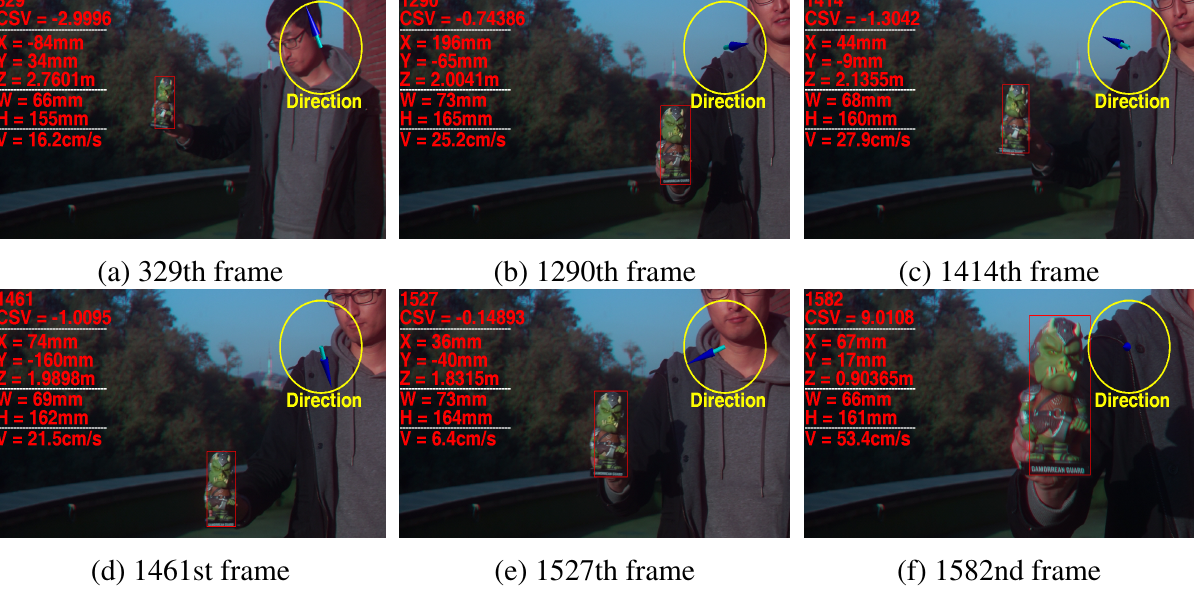
using the proposed t